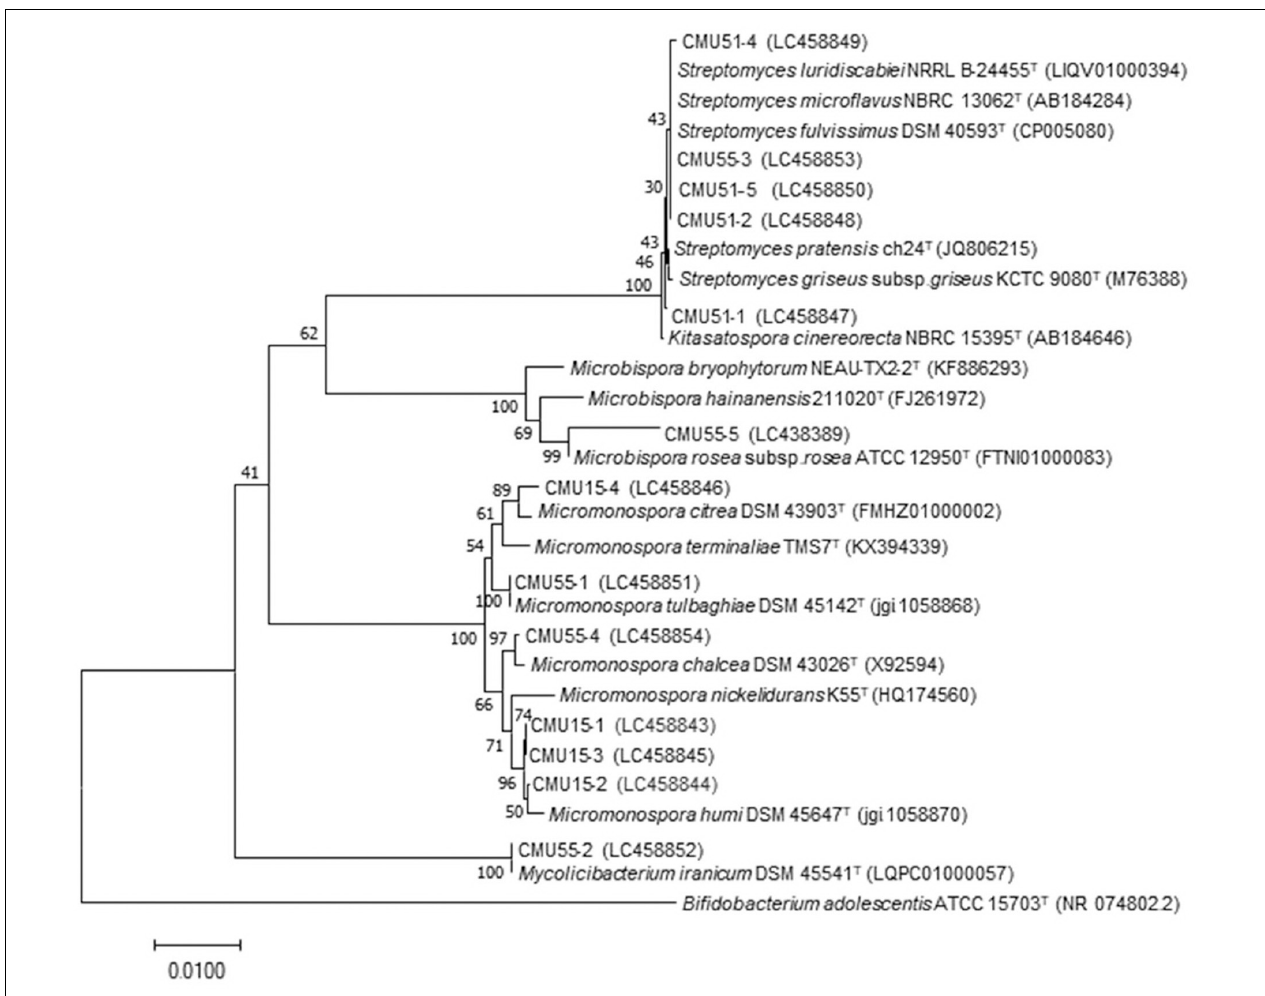
FIGURE 1 | Phylogenetic tree based on neighbor-joining analysis of 16S rRNA gene sequences from bryophytes associated actinobacteria and their nearest neighbors. The numbers at branch nodes indicate bootstrap percentages derived from 1,000 replications. Bar, 0.01 substitutions per nucleotide